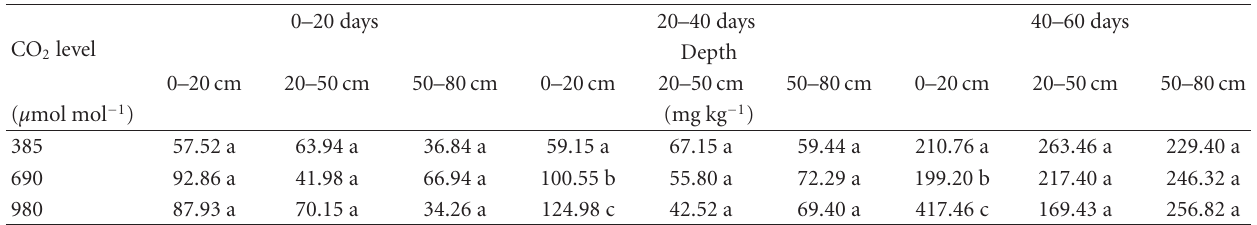
Table 2: E ff ect of atmospheric CO 2 concentration on soil C mineralization during a 60-day soil incubation at three soil depth increments † .